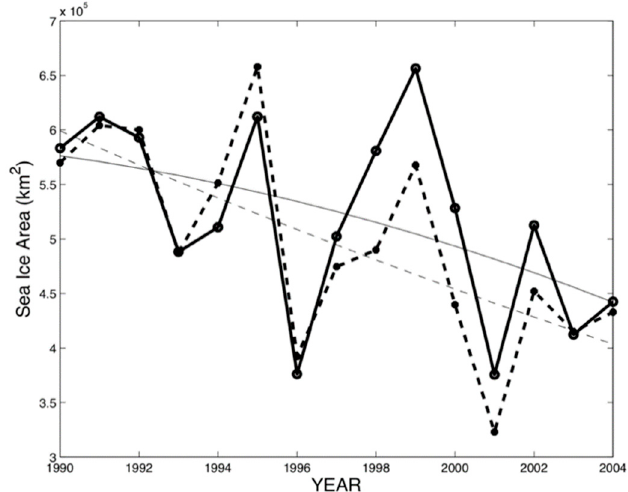
Figure 8. Interannual variation in the winter-time sea-ice areas in the Bering Sea (unit: km 2 ). The thicker solid and dashed lines are the SSM / I data and the ROMS solution, respectively. The thin solid and dashed lines are from the second order polynomial regression of the SSM / I and ROMS data, respectively. The data are yearly means. Due to the e ff ect of polar stereographic projection, the true SSM / I sea-ice area is possibly smaller than the area shown.